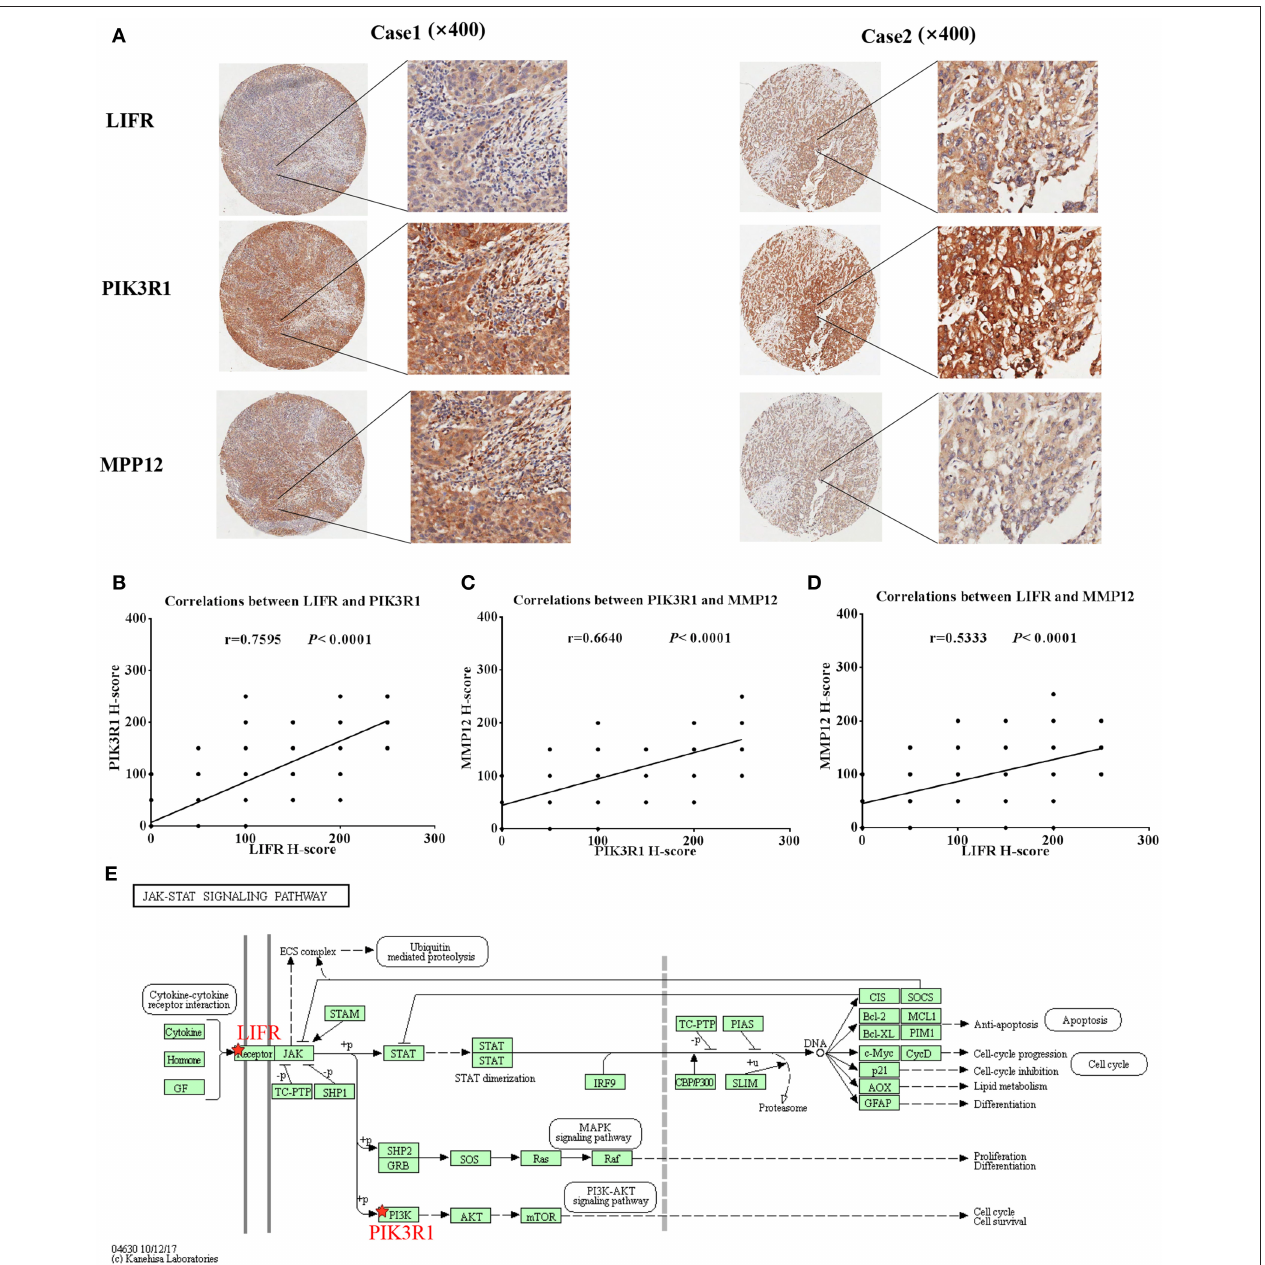
FIGURE 5 | Expression and regulation relation among LIFR , PIK3R1, and MMP12 in GBC patients. (A) LIFR , PIK3R1, and MMP12 colocalized in two representative cases of GBC tissues were detected by immunostaining. Original magnification × 400. (B) Pearson’s correlation analysis of LIFR expression with PIK3R1 expression in 80 GBC patients. (C) and (D) are representative of the relation between LIFR with MMP12 and relation between PIK3R1 with MMP12 , respectively. (E) Regulation relation between LIFR and PIK3R1 in Jak-STAT signaling pathway of KEGG.